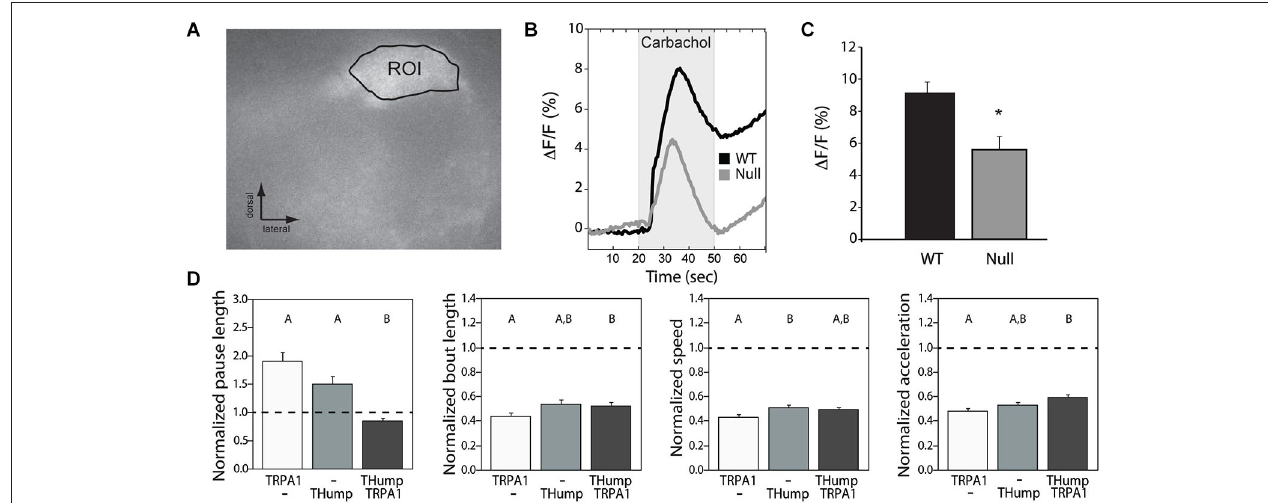
locomotion, but failed to cause a change in the other three metrics of motor behavior. Data from all groups are normalized to WT control levels which are shown as a dotted black line at 1.0 on the Y-axis of each graph. The magnitude of the deviation from the dotted line is proportional to severity of phenotype. Transgenes present in each group of animals are indicated below the histogram bars: “THump” = THump-Gal4 , and “TRPA1” = UAS-dTRPA1. As above, all transgenes were on a CASK - β mutant background. Letters indicate significant differences between groups ( P < 0.05, ANOVA with Tukey HSD). See Section Methods for details on statistical